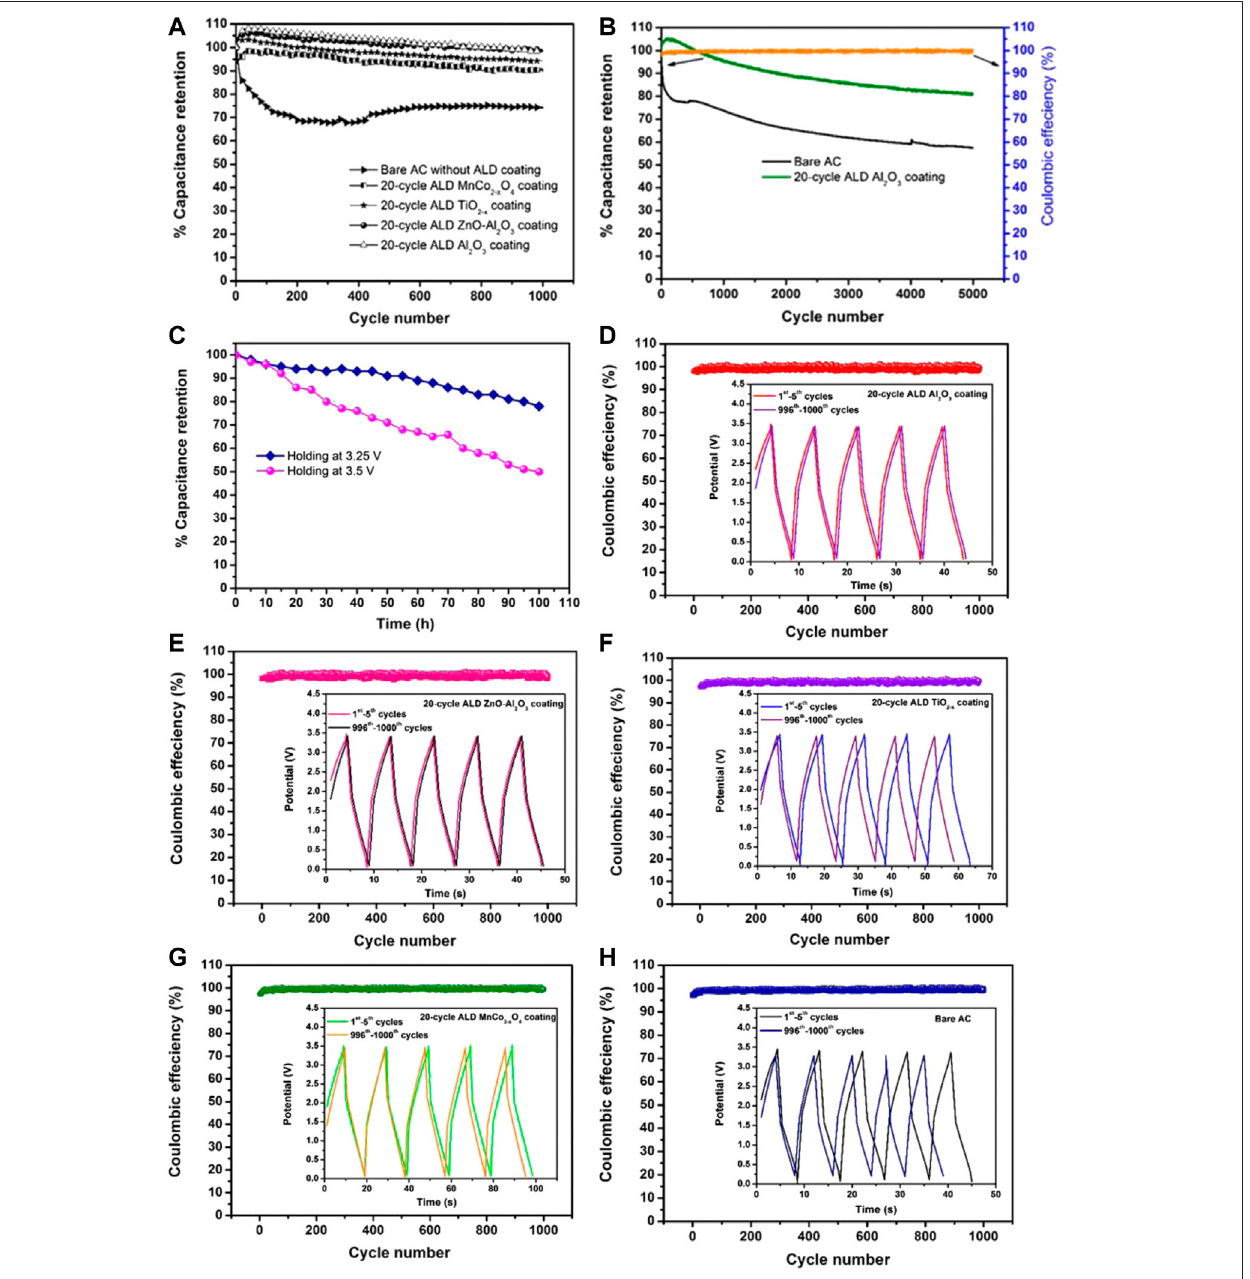
FIGURE6 |(A) Capacitance retention ofthe bare ACand various ALD oxidecoated ACelectrodescarried out at 3.5 V and at a current density of 100 mA cm − 2 till 1,000 cycles. (B) Capacitance retention of the bare AC and 20-cycle ALD Al 2 O 3 coated AC electrodes for 5,000 GCD cycles. (C) Constant voltage holding test of 20- cycle ALD Al 2 O 3 coated AC electrodes at 3.25 and 3.5 V (D – H) Coulombic ef fi ciencies along with the representative shapes of GCD curves for 1 – 5th and 996 – 1000th cycles of 20-cycle ALD coated